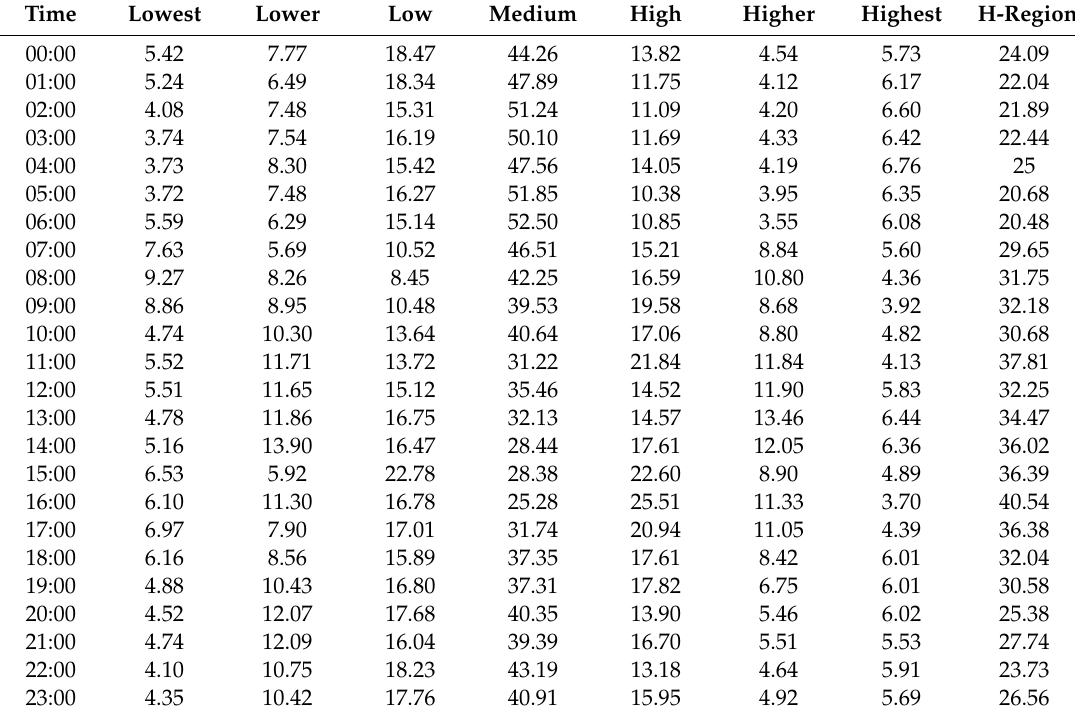
Table 5. The proportion (%) of different temperature zones and the H-region according to the mean hourly temperatures for Changchun during August 1–31, 2015. The largest and smallest proportions are highlighted with dark and light gray shadows, respectively.